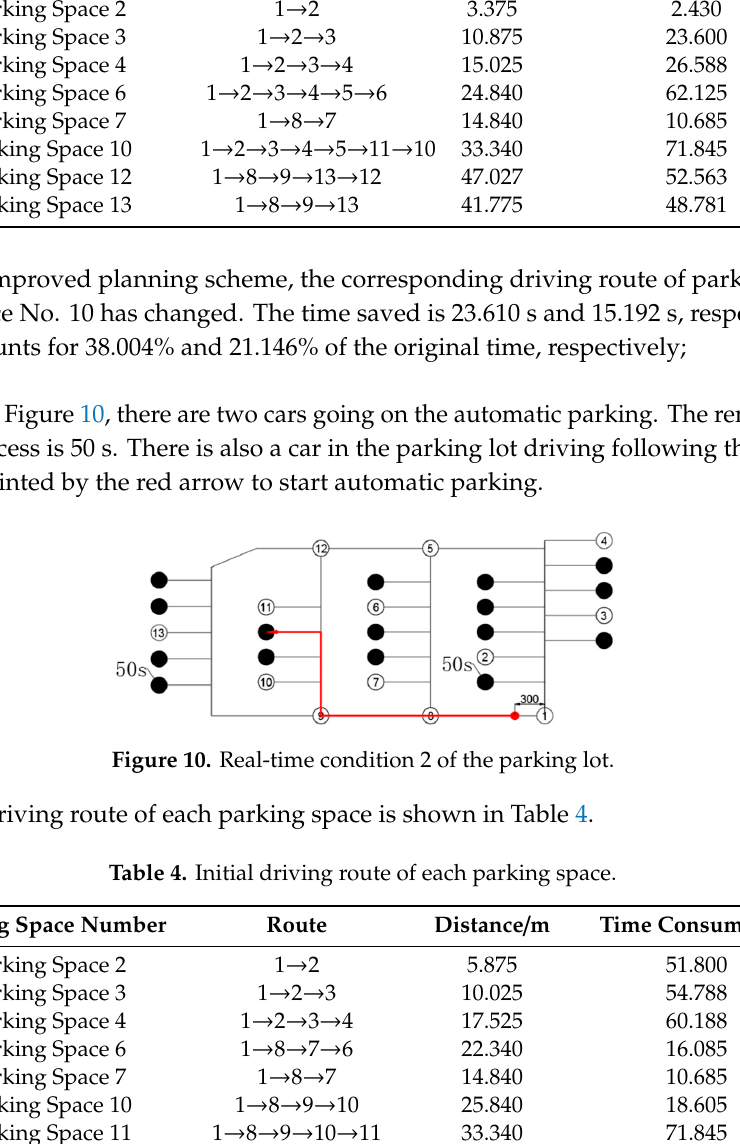
Table 3. Driving route of each parking space under the improved algorithm.